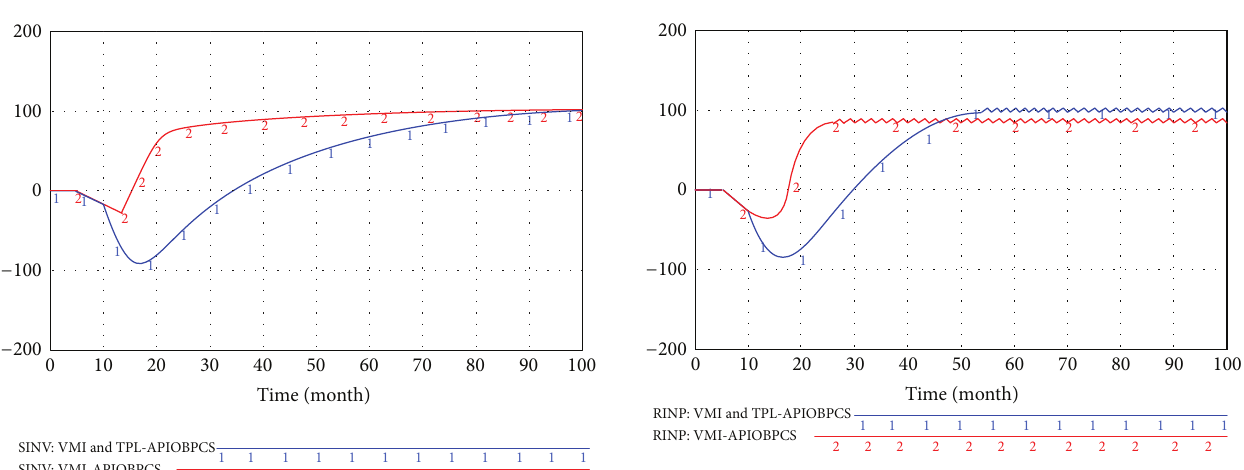
Figure 18: The comparison of downstream inventory level fluctua- tion.